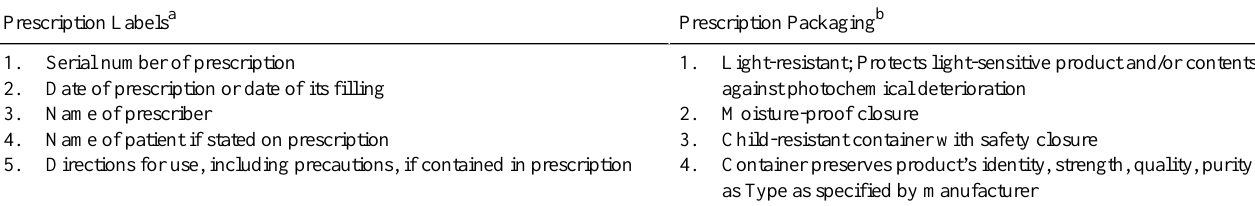
Table 1. Guidelines for prescription labeling and